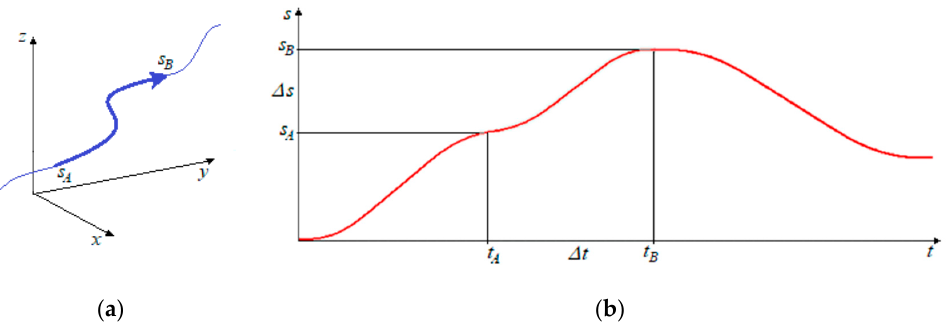
Figure 1. ( a ) Example of the trajectory and ( b ) example of the position law of motion.